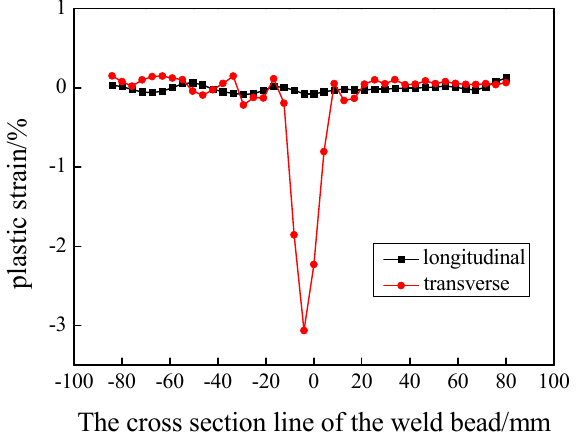
Figure 7. Plastic strain distribution on the cross-sectional line of the thin bending plate weld. In the weld zone, due to the solidification of the liquid metal after cooling, transverse shrinkage occurred, and the maximum shrinkage was observed at the center of the weld. In the heat-affected zone, due to the tensile stress caused by the cooling of the weld and the influence of its own thermal expansion, tensile plastic deformation occurred in the transverse direction, and the transverse strain was positive. Due to the low temper- ature gradient and the small tensile stress in the area outside the heat-affected zone, the plastic deformation in the transverse direction was very small, and the transverse strain